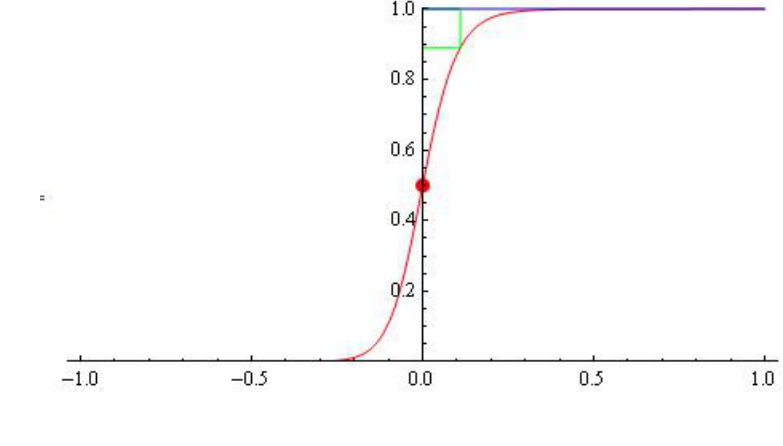
Fig. 1. The model (5) for β = 21 , k = 20 ; H–distance = 0 . 109948 , d l = 0 . 0454545 , d r = 0 . 179129